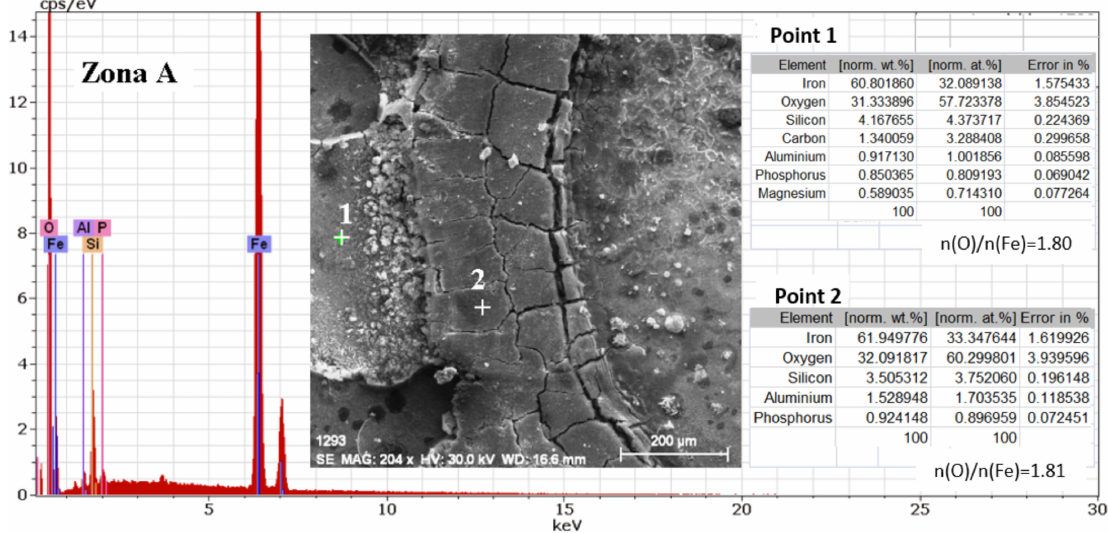
Figure 20. EDS, corrosion zone A, and point composition on the surface of the nodular cast iron immersed for 65 days in